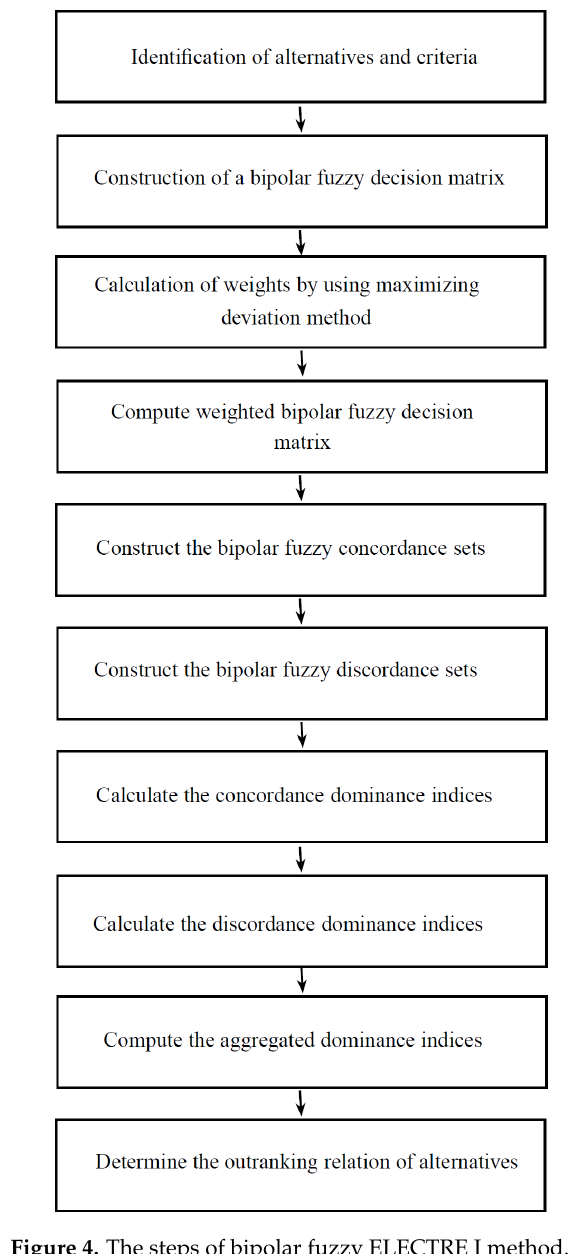
Figure 4. The steps of bipolar fuzzy ELECTRE I